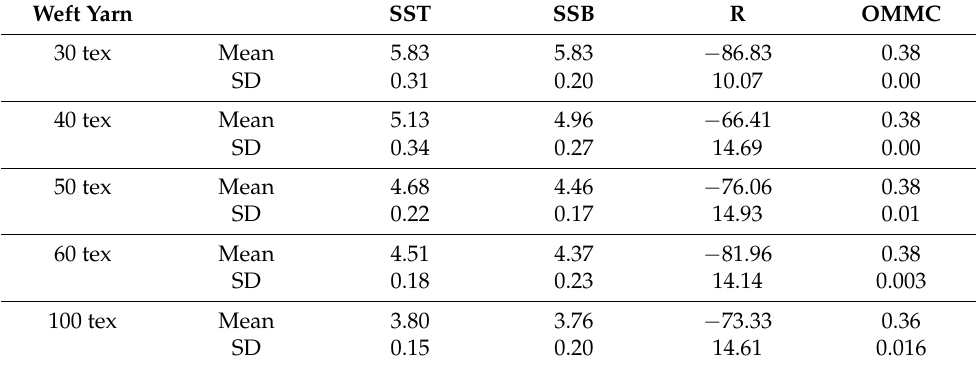
Table 3. The results from the MMT;